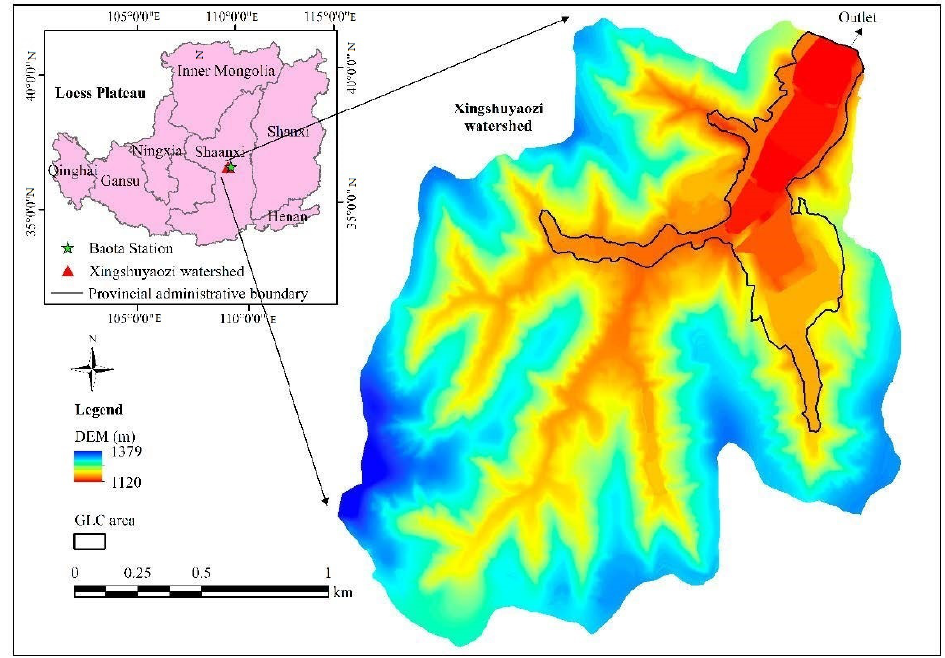
Figure 1. Location and the DEM after GLC (in 2019) of Xingshuyaozi watershed.